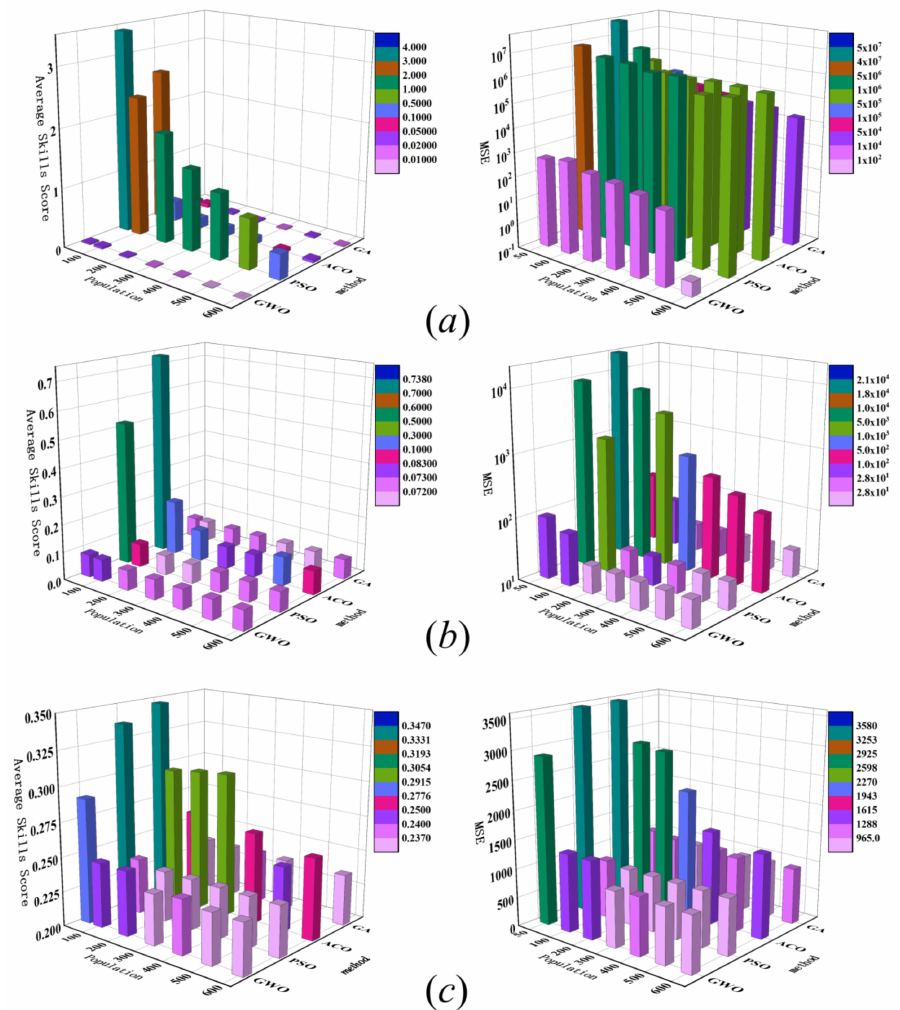
Figure 5. Comparison results of different optimization algorithms with different population numbers in ( a ) simulation case, ( b ) run 17 and ( c ) run